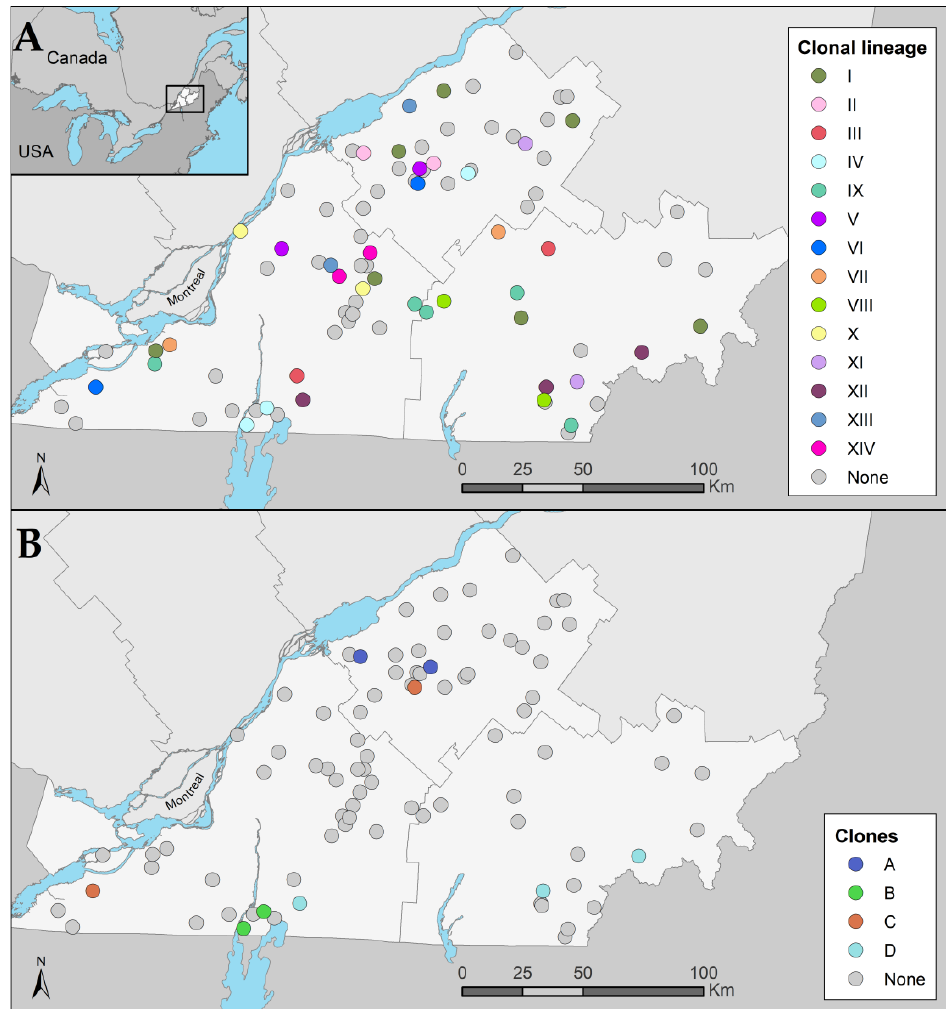
Figure 4. Geographical distribution of isolates according to the definition of: ( A ) Clonal lineage: isolates with the same sequence type (ST), serogroup, phylogroup, and fimH gene. ( B ) Clone: isolates with 12 or fewer SNP differences from each other. Jittering was used for the farm location to preserve their confidentiality. The light grey zone represents the three administrative regions of the study area: Montérégie, Centre-du-Québec, and Estrie. The medium grey zone represents the other administrative regions of Quebec. A Lambert conformal conic projection (NAD 1983) was used for mapping.